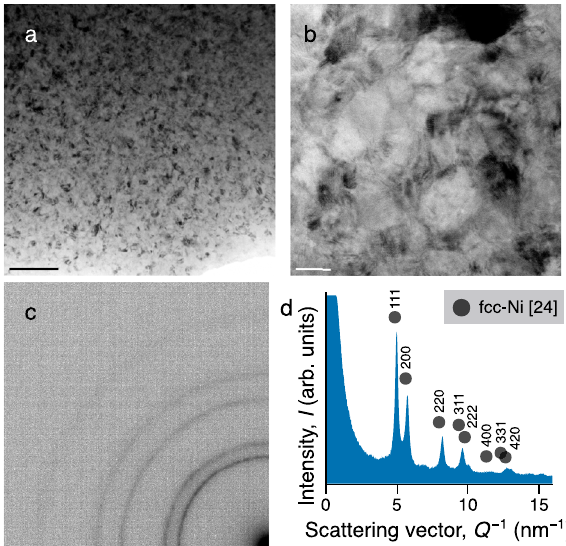
Figure 2. TEM observation of the electrodeposited nanocrystalline FeCoNi MEAs. ( a ) BF-TEM image in a wide area and ( b ) BF-STEM image in high magnification of sample C. The scale bars represent 100 nm and 10 nm, respectively. ( c ) Electron diffraction pattern and ( d ) intensity